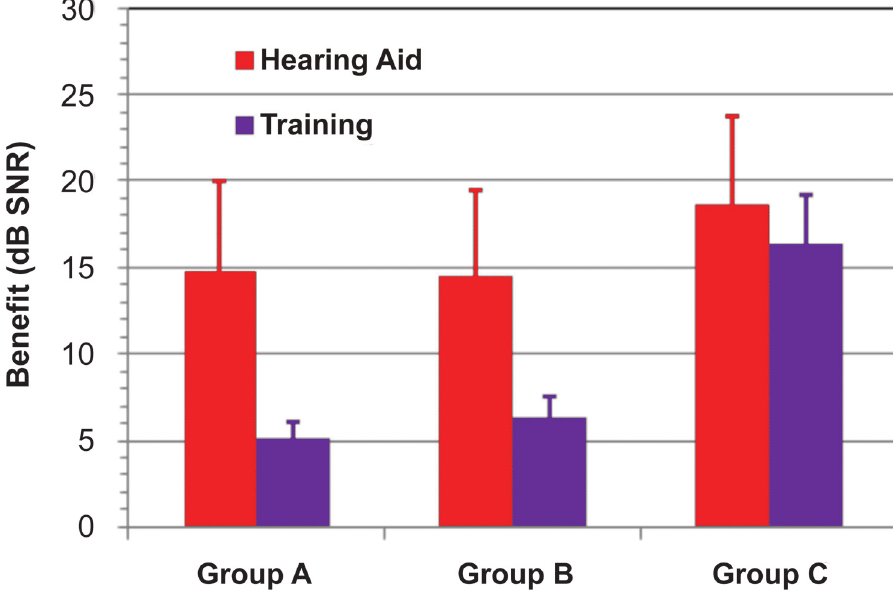
Fig 5. Hearing aid and training benefit for different consonant groups. Data from 11 listeners who participated in both studies. Error bars show standard errors.